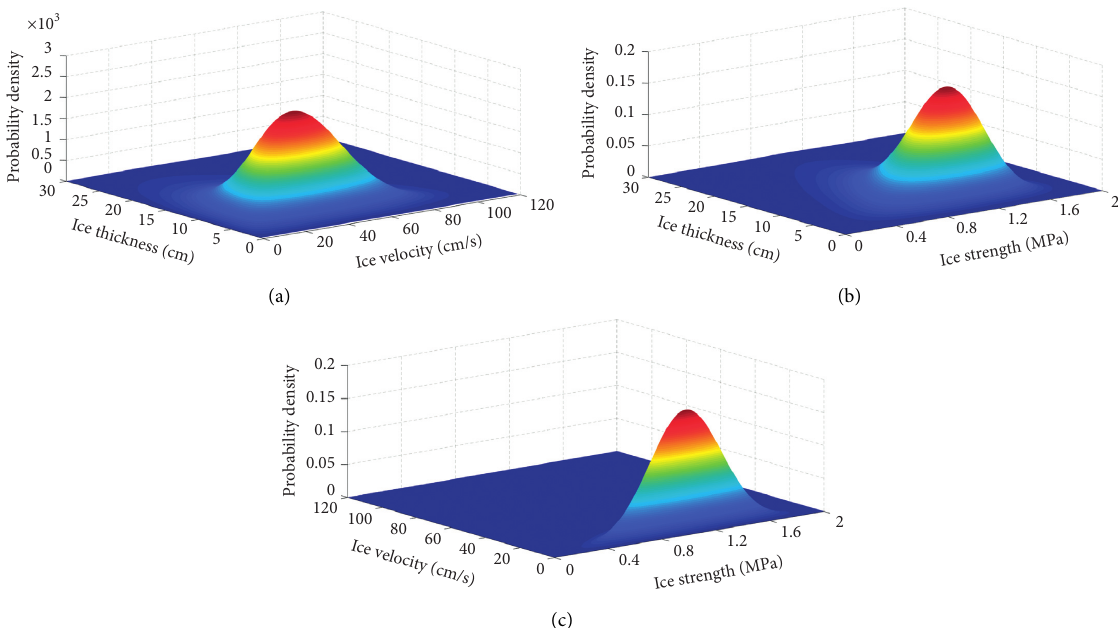
Figure 8: The joint probability density for (a) ice thickness-ice velocity; (b) ice thickness-ice strength; (c) ice velocity-ice strength.